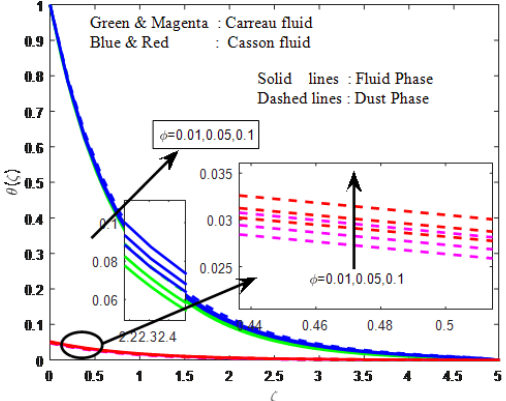
Fig. 2: Impact of M on velocity profiles.